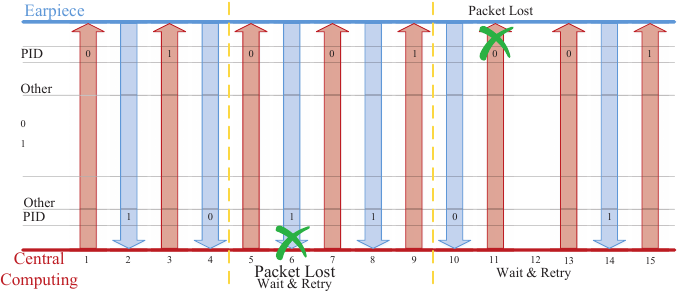
Figure 13. Flow of packet